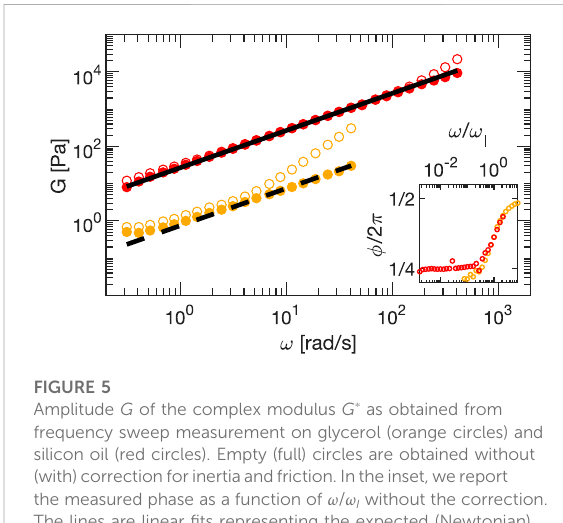
FIGURE 6 Storage (circles) and loss (triangles) moduli relative to (A) Sylgard (elastic sample) and (B) Carbopol 5% (yield stress sample) as a function of the oscillation frequency ω in oscillatory shear tests. Lines correspond to storage (continuous) and loss (dashed) moduli obtained with a commercial rheometer. Frequency sweeps are made at constant strain (1.5 ± 0.2% and 1.42 ± 0.09% for Sylgard and Carbopol, respectively). All data are corrected for inertia and sliding friction as described in the main